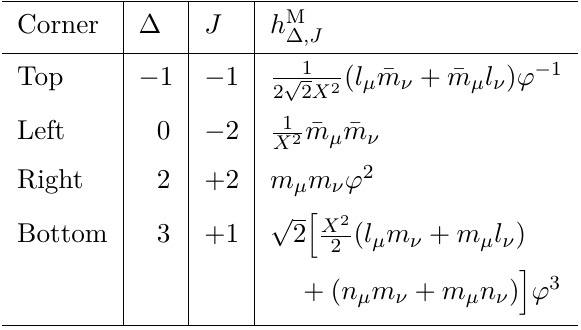
Table 19. Elements of the celestial diamond corresponding to spin memory.